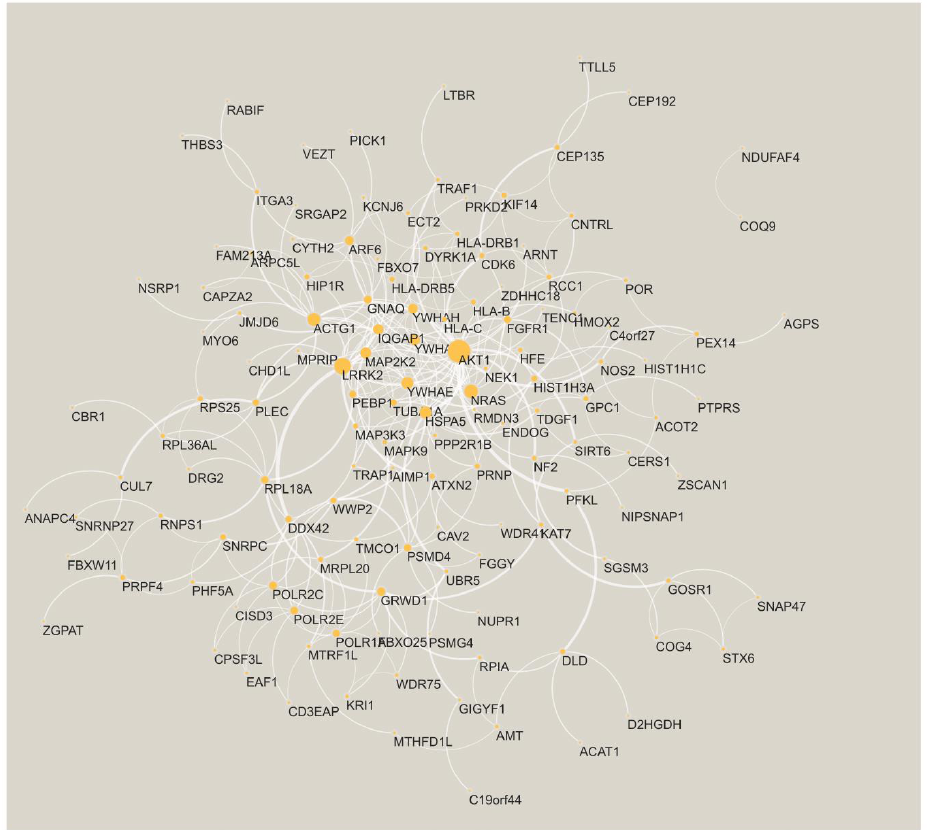
Figure 3. The PPI network is formed by the AD shared genes. The node size is proportional to its degree. The edge width is proportional to the confidence score from STRING